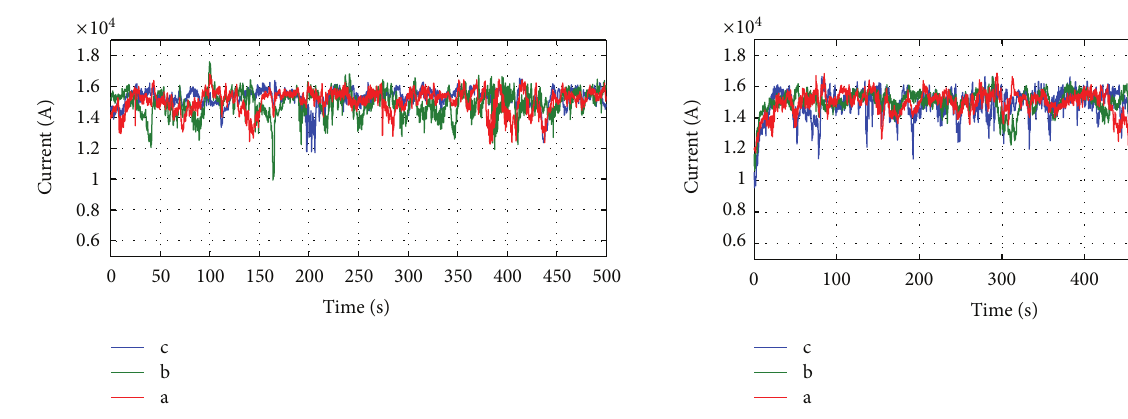
Figure 16: Three-phase current during the HIL test.